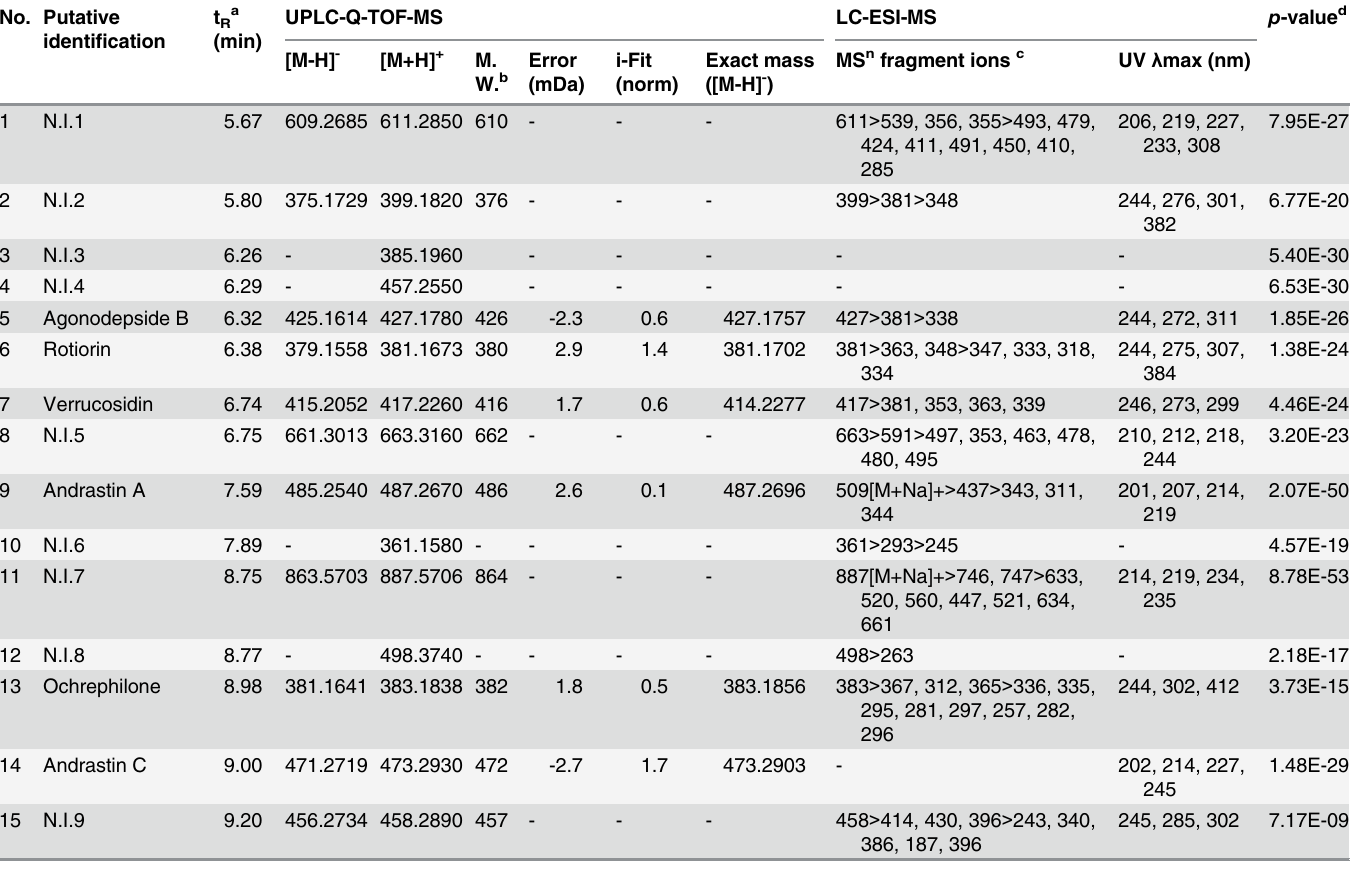
Table 1. Putative identified metabolites from the Penicillium expansum 40815 according to different fermentation condition on the basis of UPLC-QTOF-MS and LC-ESI-MS data. No. Putative identi fi